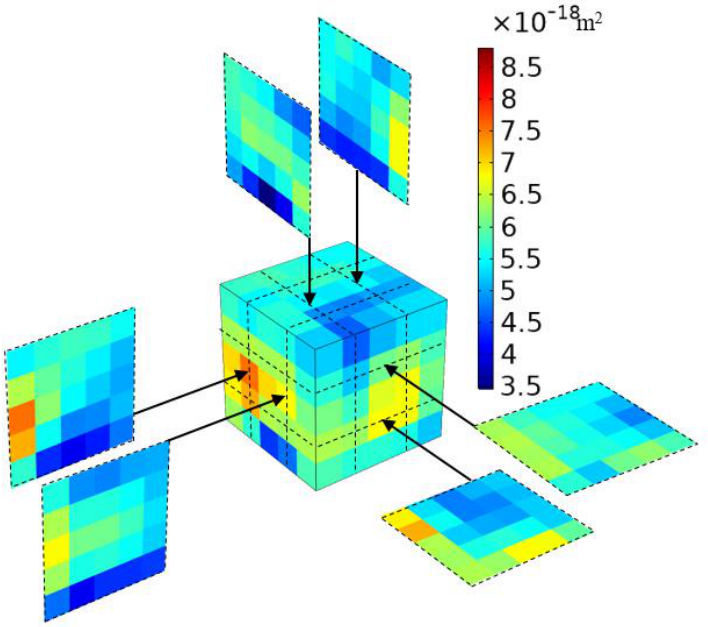
Figure 13. Spatial distribution of permeability within the cuboidal sample of Stanstead granite. ( Lower surface permeability records).